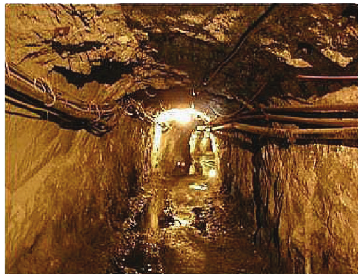
Figure 2: CANMET mine gallery-LOS case.